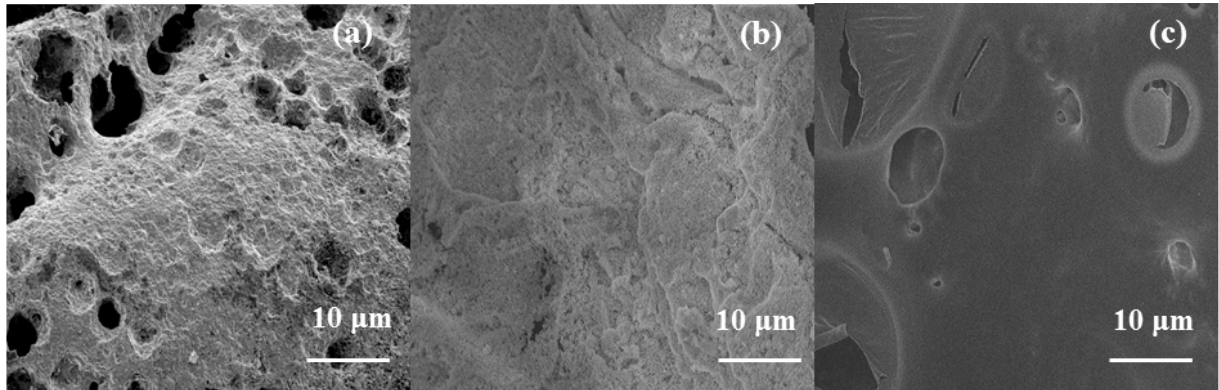
Figure 11. SEM images of carbon residues of TPU/MoS 2 ( a ), TPU/NiFeTb-LDH ( b ) and TPU/NiFeTb- LDH/MoS 2 ( c ).